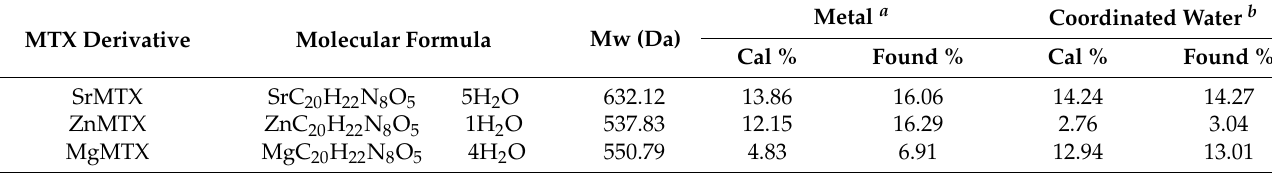
Table 1. Molecular parameters and molecular formulas of metal-MTX complexes.